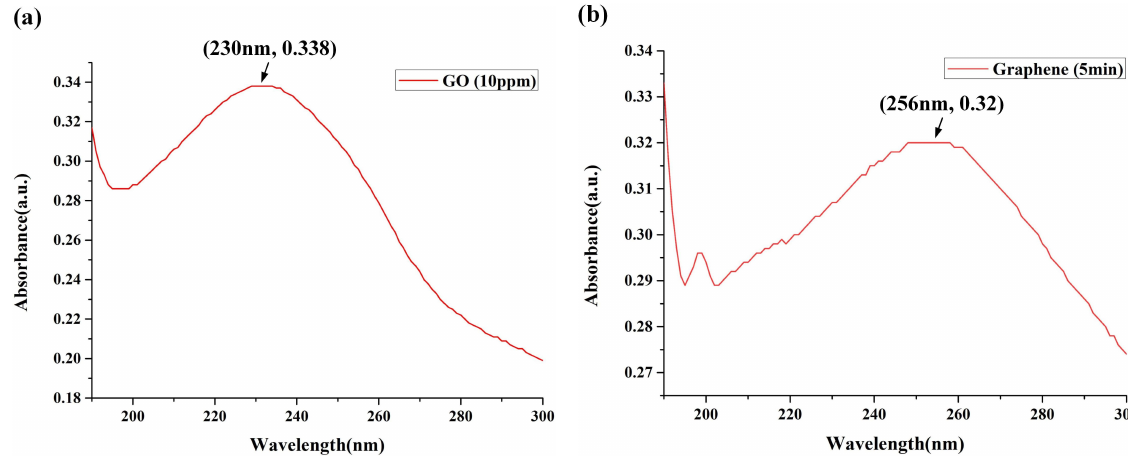
Figure 12: 10 ppm UV-Vis: (a)GO solution; (b)graphene